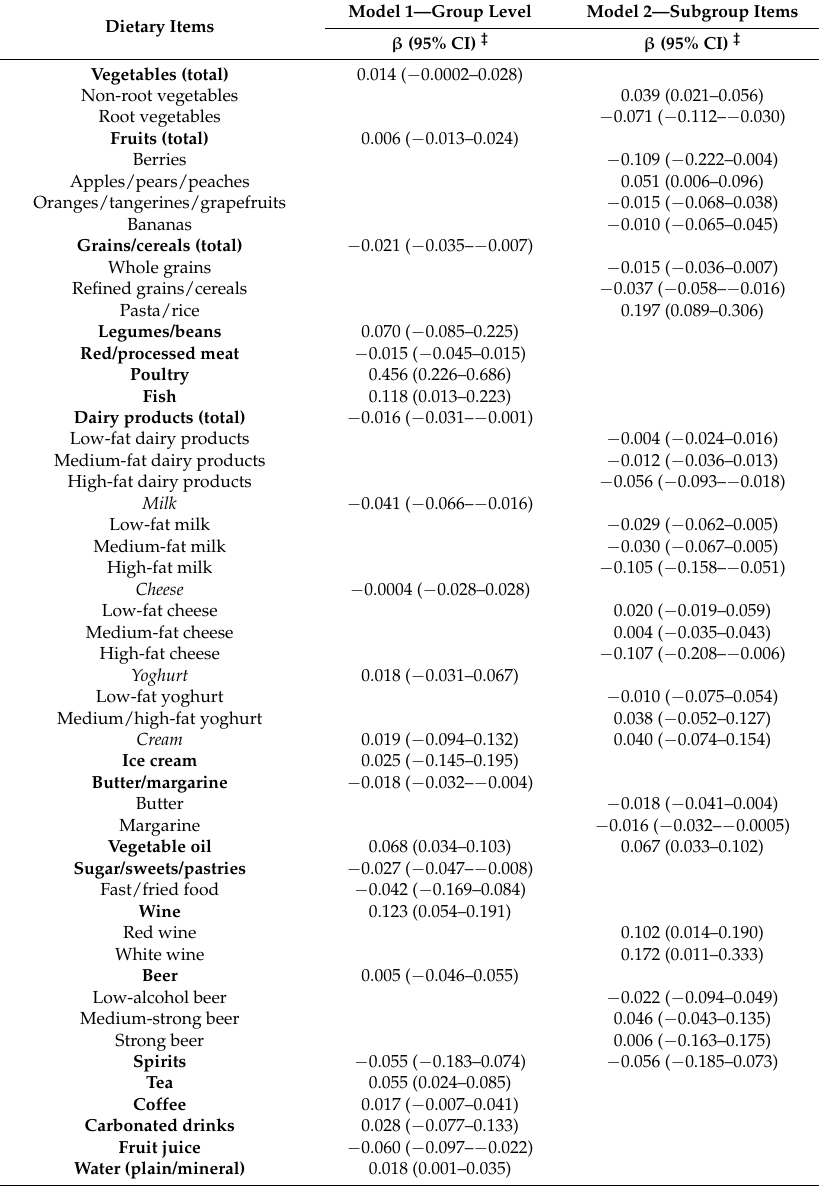
Table 1. β -coefficients (95% confidence intervals) for the associations between intake of individual dietary items and rate of change in MMSE score over 6